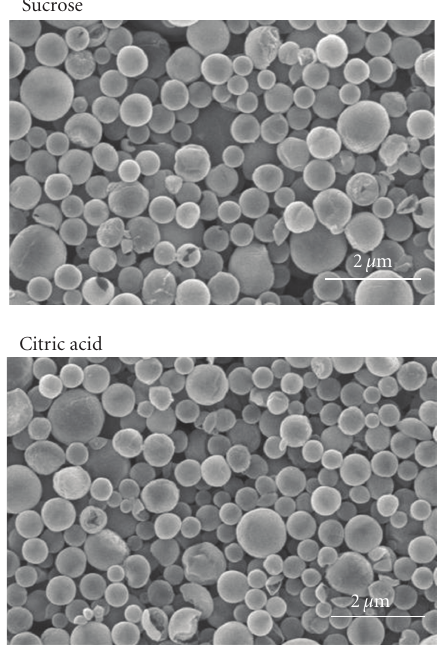
Figure 2: SEM photographs of LiFePO 4 /C powders obtained from sucrose and citric